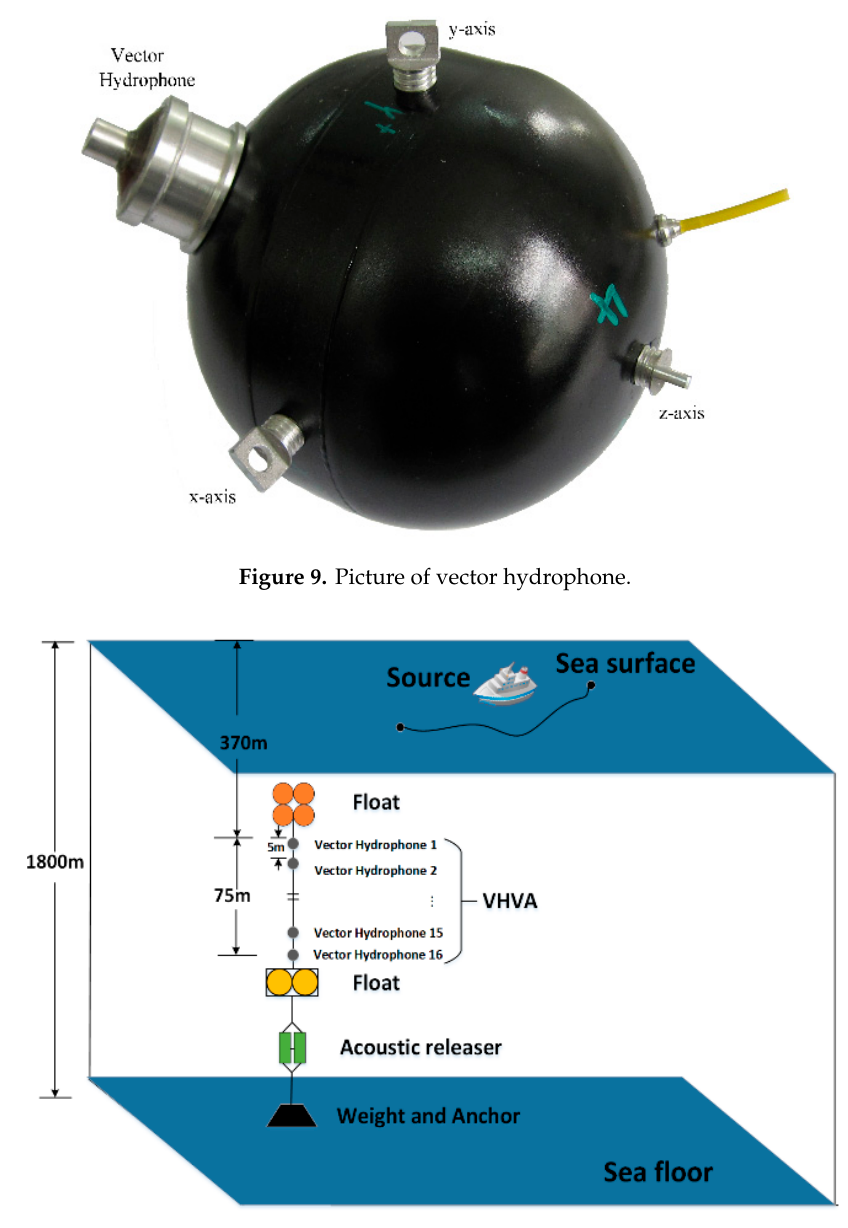
Figure 10. Experiment configuration.